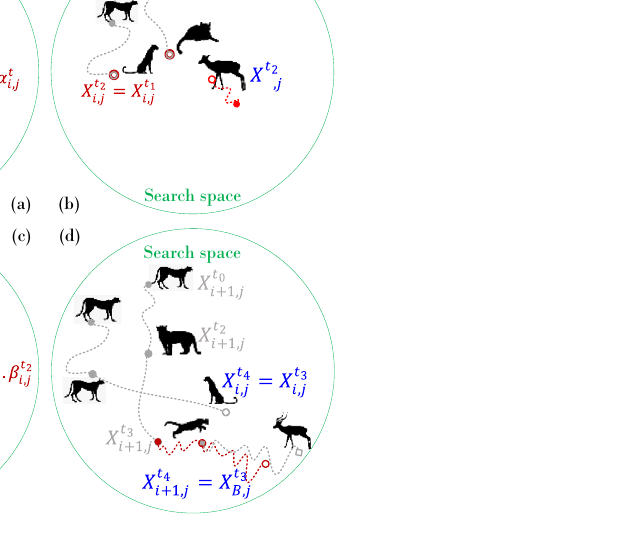
Figure 2. Graphical information of CO’s